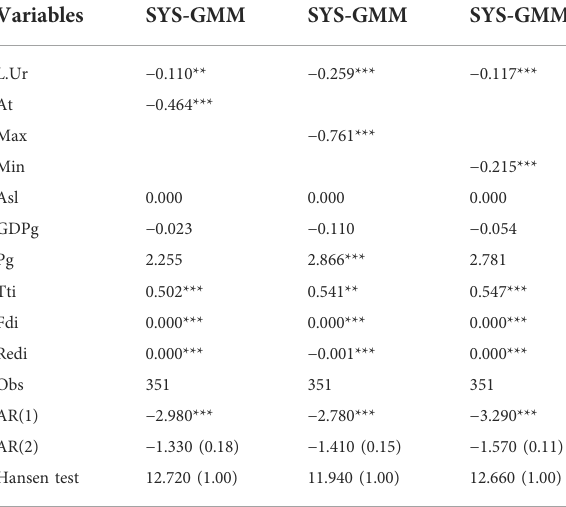
TABLE 8 Dynamic panel regression results.